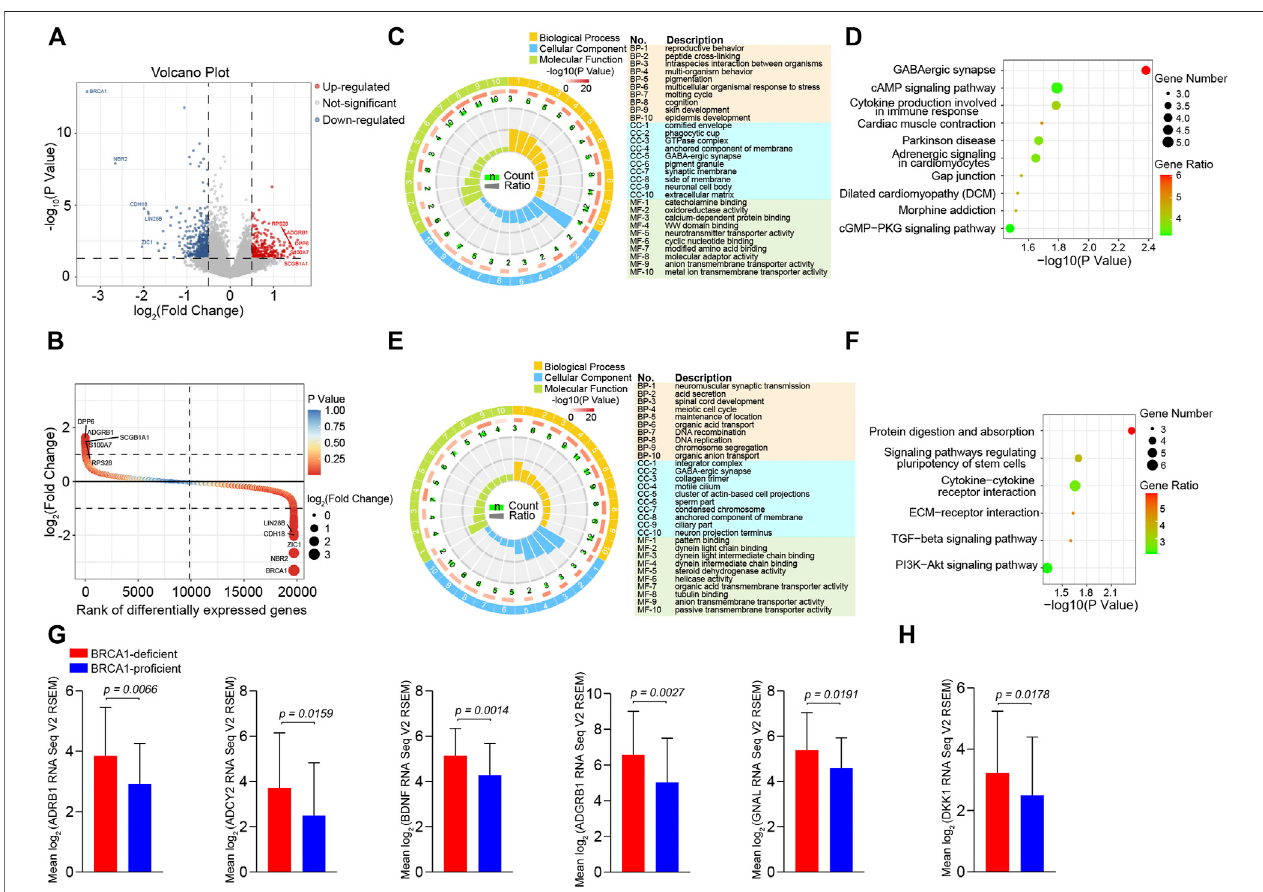
FIGURE 3 | Differentially expressed genes analysis between BRCA1-de fi cient and BRCA1-pro fi cient ovarian cancer patients. (A) Volcano plot of differentially expressed genes (fold change > 1.5, p value < 0.05) between BRCA1-de fi cient ( n = 29) and -pro fi cient ( n = 275) patients. In total, 447 differentially expressed genes including 176 up-regulated genes (red) and 271 down-regulated genes (blue) were identi fi ed in BRCA1-de fi cient ovarian cancer patients. (B) Rank plot of differentially expressedgenesaccordingtogeneexpressingdifference.Thehighest fi veup-regulatedanddown-regulatedgenesinBRCA1-de fi cientpatientsarelabelledinthe left and right in the plot, respectively. (C) GO enrichment analysis of 176 up-regulated genes. The fi rst lap indicates top 10 GO terms in “ biological process, ” “ cellular component, ” and “ molecular function, ” the description of each item is listed in the right. p value and the number of the genes for corresponding GO terms are shown in the secondand thethirdlaps,respectively. Enrichmentfactorsofeach GOterm areshown inthefourth lap. (D) KEGG analysisof176up-regulatedgenes.Top 10most signi fi cantly pathways are shown in the plot. The color key from green to red represents the gene ratio. Dot size indicates the number of the genes in corresponding pathway. (E) GOenrichmentanalysisof271down-regulatedgenes.The fi rstlapindicatestop10GOtermsin “ biologicalprocess, ”“ cellularcomponent, ” and “ molecular function, ” the description of each item is listed in the right. p value and the number of the genes for corresponding GO terms are shown in the second and the third laps, respectively. Enrichment factors of each GO term are shown in the fourth lap. (F) KEGG analysis of 271 down-regulated genes. Top six most signi fi cantly pathways are shown in the plot. The color key from green to red represents the gene ratio. Dot size indicates the number of the genes in corresponding pathway. (G) Comparison of ADRB1 , ADCY2 , BDNF , ADGRB1 , and GNAL expression between BRCA1-de fi cient ( n = 29, red) and -pro fi cient ( n = 275, blue) patients. (H) Comparison of DKK1 expression between BRCA1-de fi cient ( n = 29, red) and -pro fi cient ( n = 275, blue) patients.